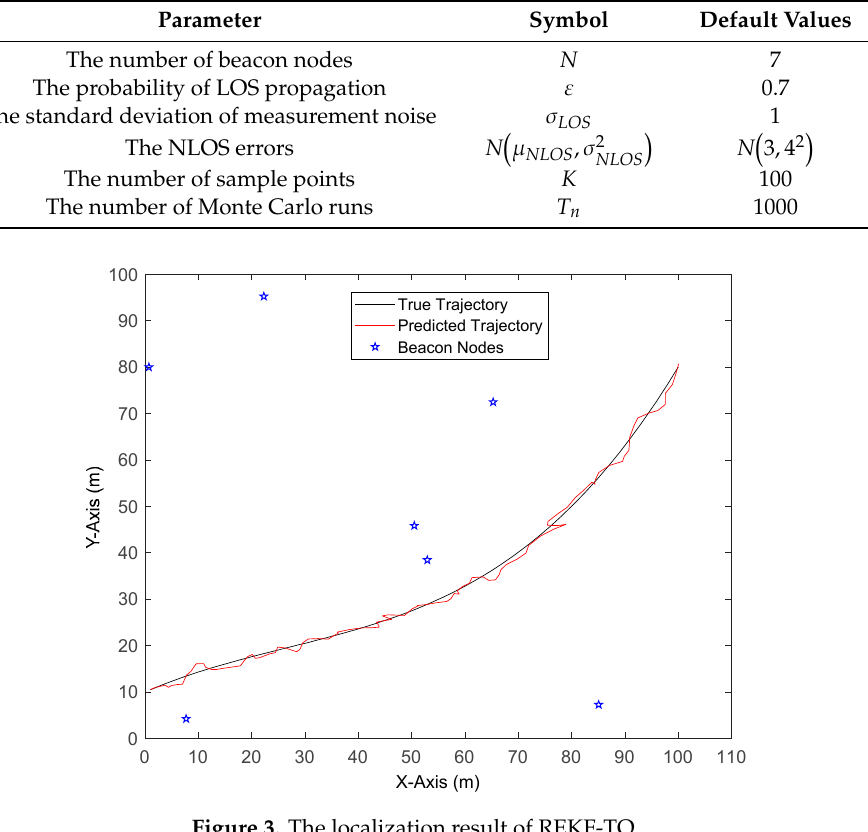
Figure 3. The localization result of REKF-TQ.